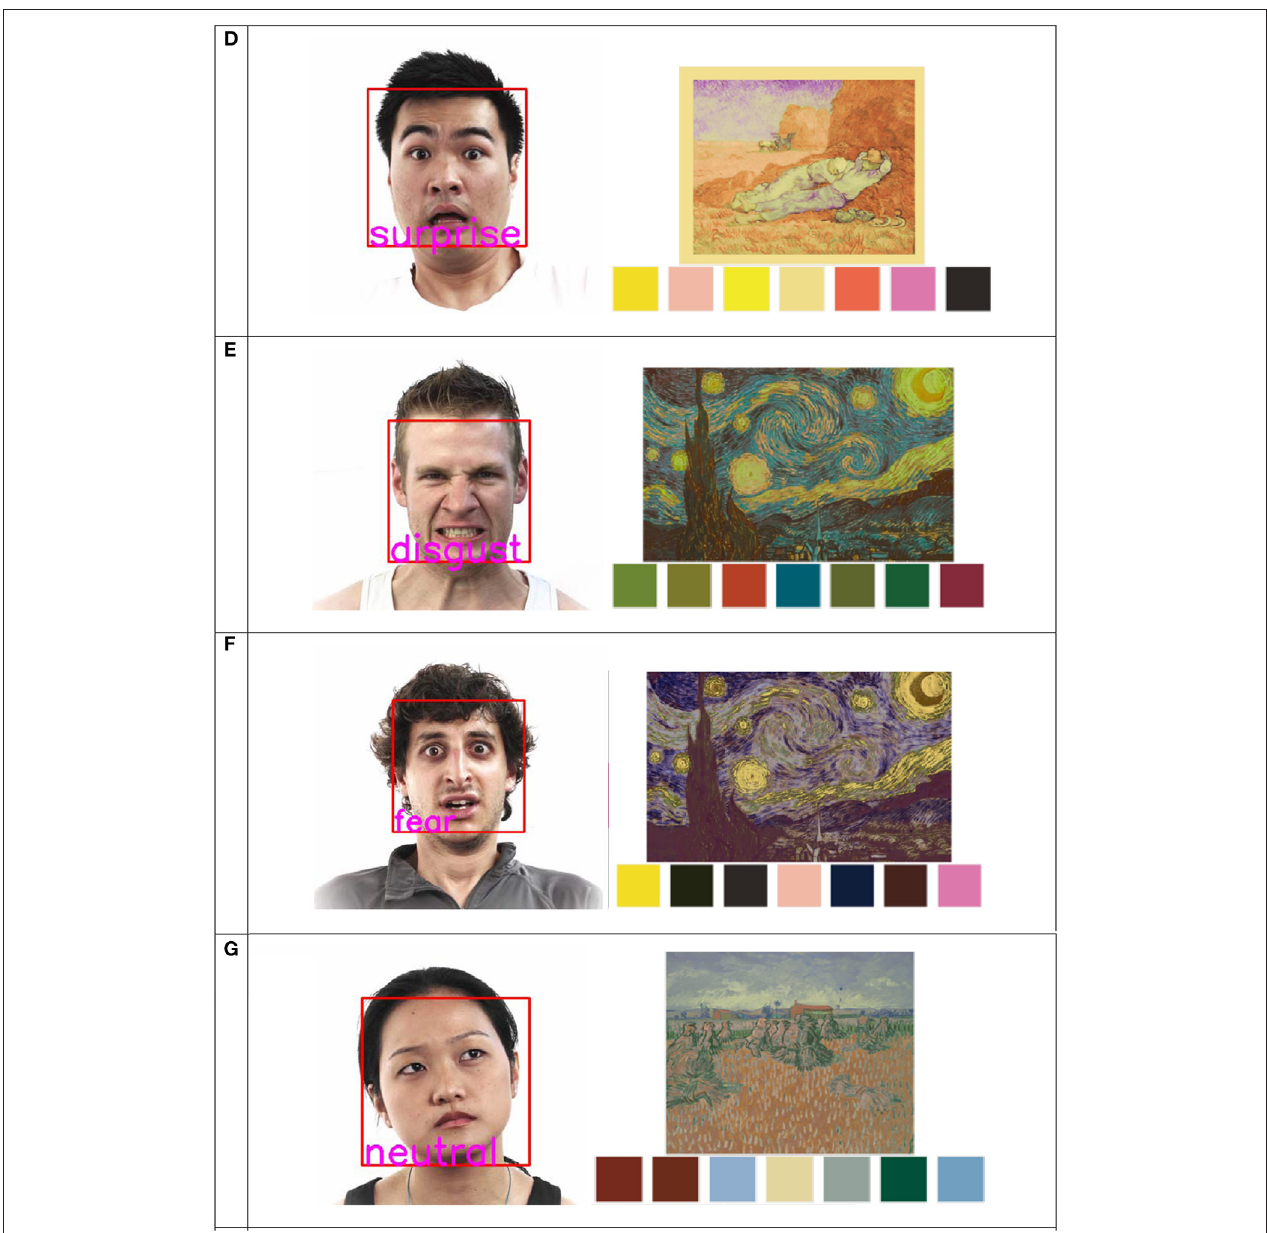
FIGURE 10 | A derivative picture of (A) happy, (B) sad, (C) angry, (D) surprise, (E) disgust, (F) fear, and (G) neutral. Facial images are from the public dataset fer2013, which can be downloaded at https://www.kaggle.com/deadskull7/fer2013.